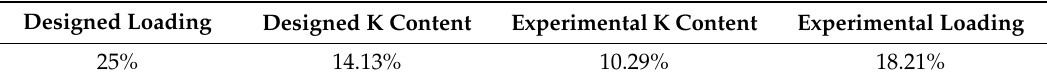
Table 1. Experimental loading of